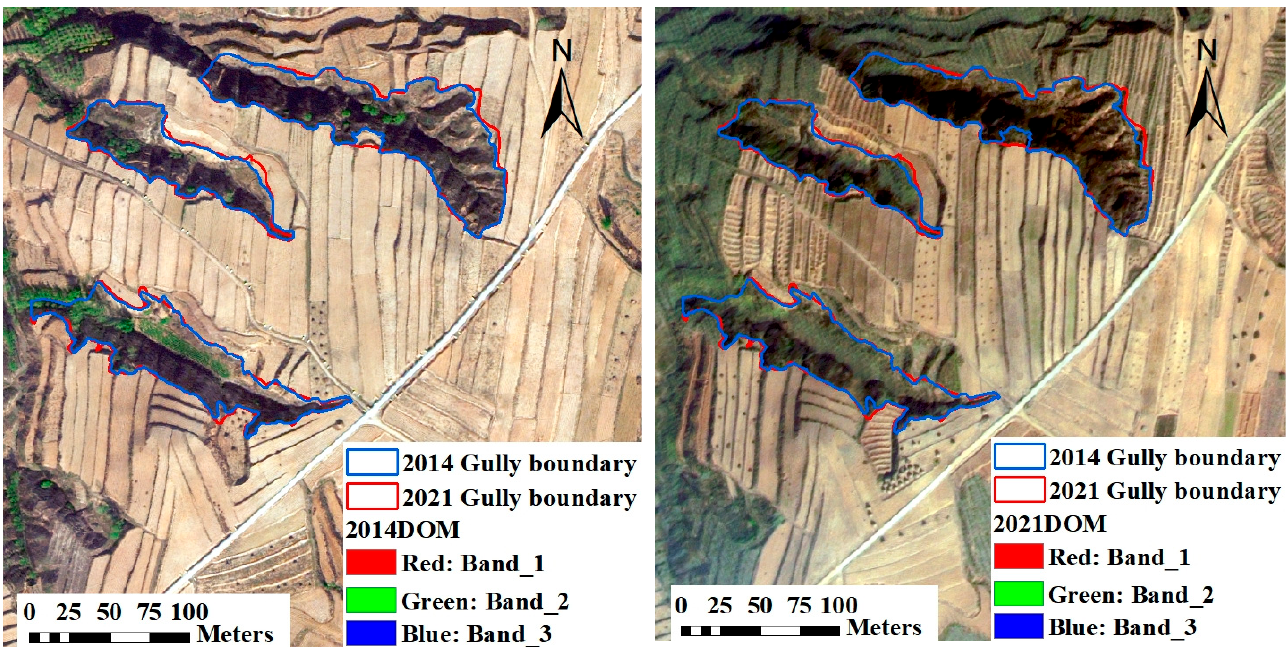
Figure 10. An example of gully area increase.